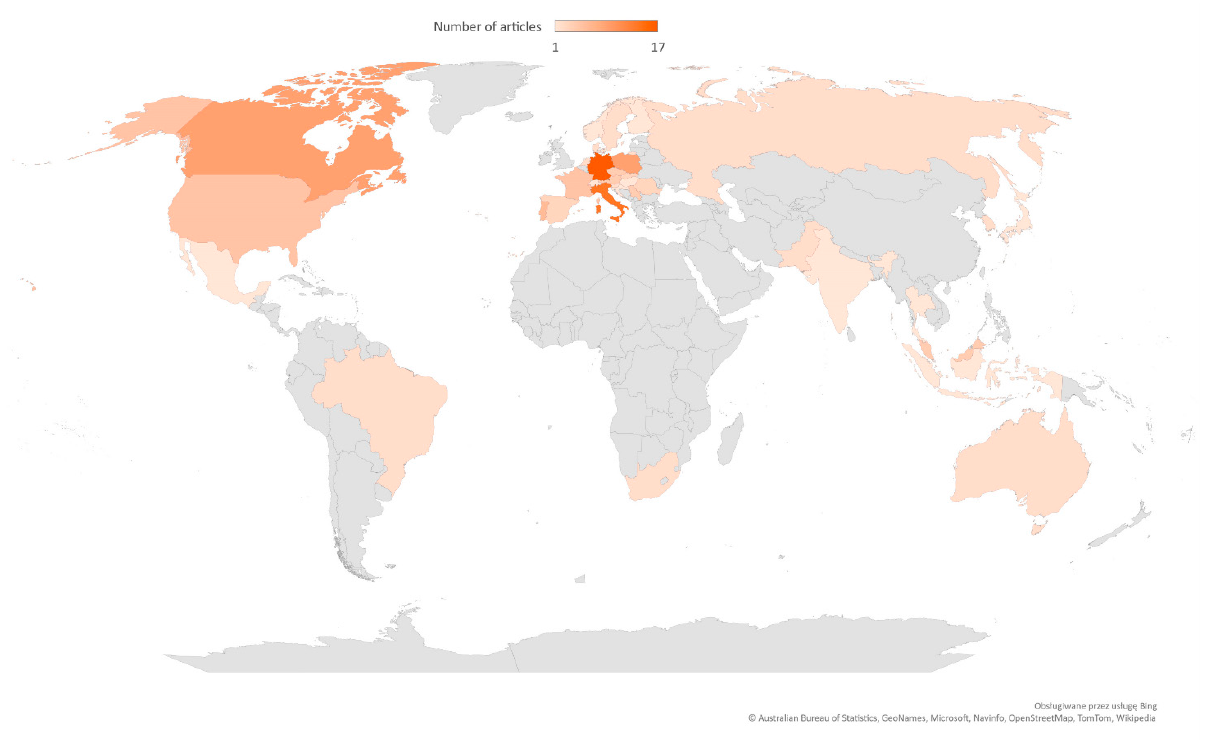
Figure 9. Scientific contribution by country and geographic region related to Industry 4.0 in the SME sector; Source: own study.